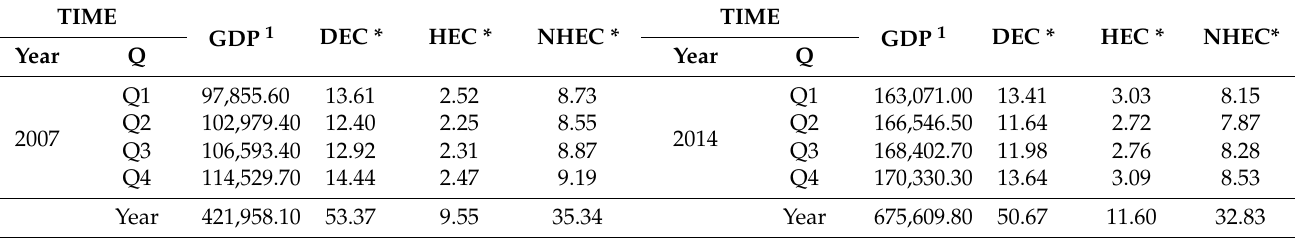
Table A1. Time series for GDP and energy consumption (DEC, HEC, NHEC) for the period 2007–2020.